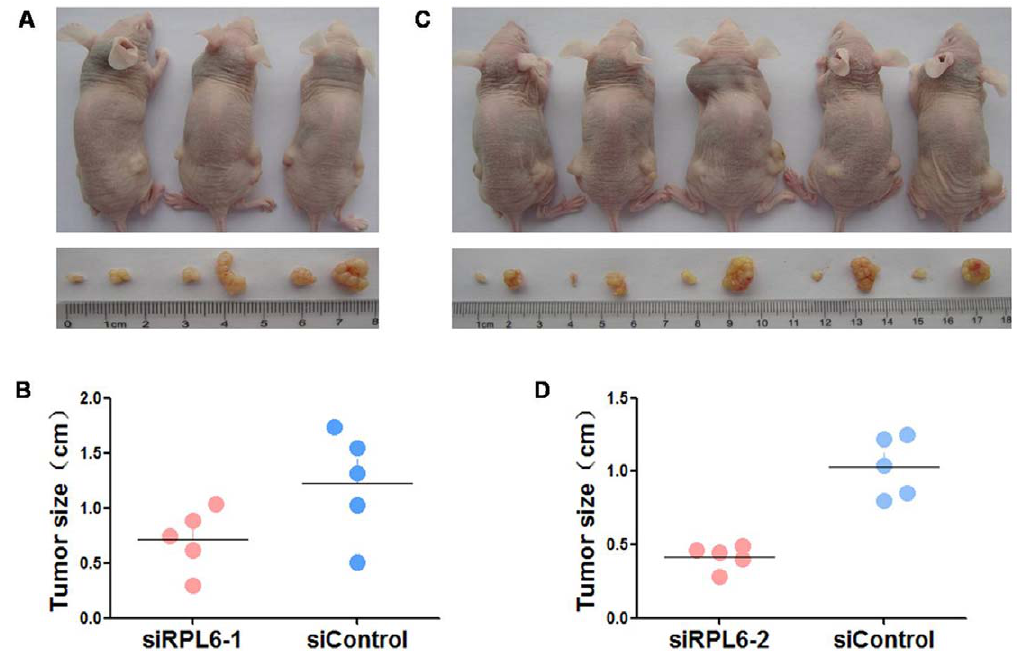
Figure 4. Down-regulation of RPL6 inhibits tumorigenesis in vivo. A. SGC7901 cells stably transfected with RPL6-specific siRNA1 (left) or with RPL6-scramble siRNA were injected into nude mice. B. Four weeks after the injection, mice were photographed and killed. Tumor sizes were measured. Error bars indicate mean 6 SD. p , 0.05 compared with the control group. C. SGC7901 cells stably transfected with RPL6-specific siRNA2 (left) or with RPL6-scramble siRNA were injected into nude mice. D. Four weeks after the injection, mice were photographed and killed. Tumor sizes were measured. Error bars indicate mean 6 SD. p , 0.05 compared with the control group.